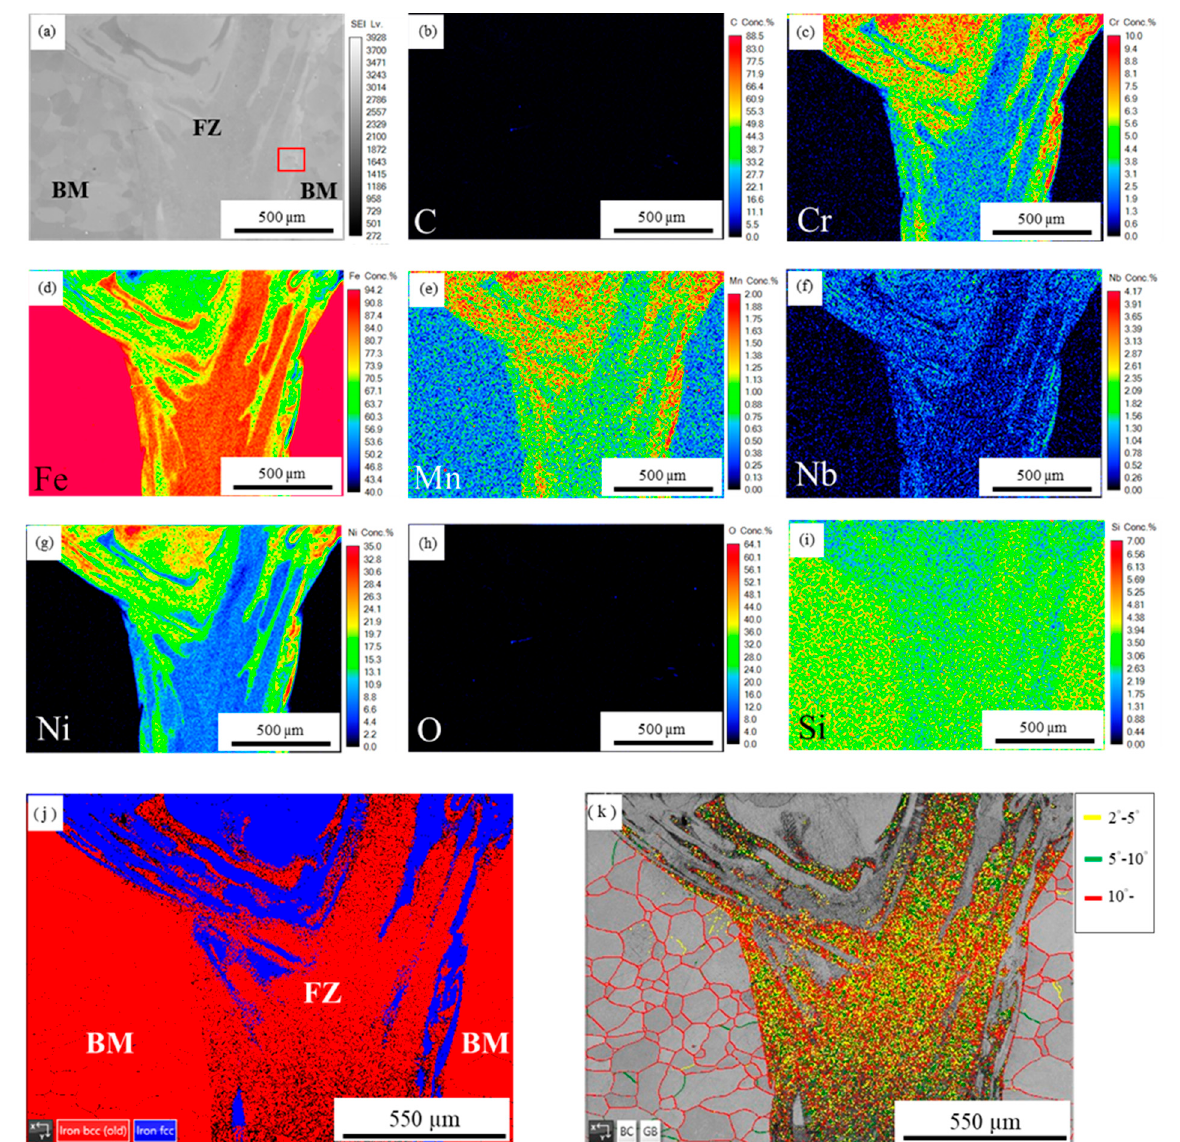
Figure 2. The cross section of the laser weldment with 3.0 m/min IN82 wire feeding rate: ( a ) EPMA SEI, ( b – i ) WDS quantitative mappings of C, Cr, Fe, Mn, Nb, Ni, O and Si in at%, ( j ) EBSD crystallographic map, ( k ) EBSD boundary misorientation